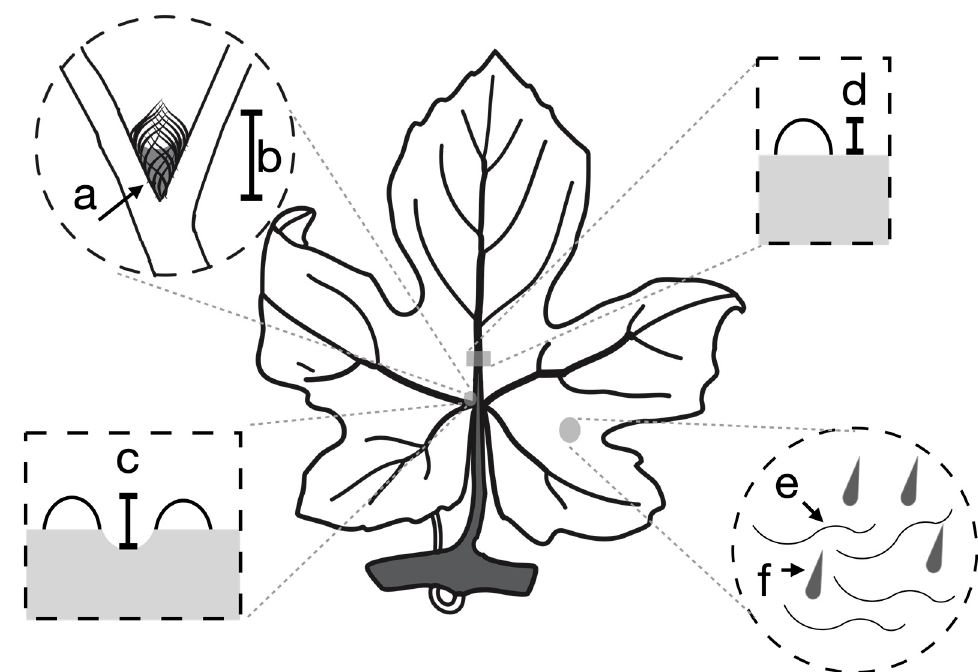
Figure 2. The location of scored phenotypes on the grape leaf. Domatia density ( a ) and size ( b ) were measured on the most basal primary vein axil on the left abaxial side of the leaf. Pit depth was measured as the difference between the height of the most basal primary vein axil on the left abaxial side of the leaf ( c ) and the height of the main vein above the leaf lamina halfway between the primary and secondary axils ( d ). The presence or absence of leaf hairs ( e ) and bristles ( f ) was measured on the abaxial leaf